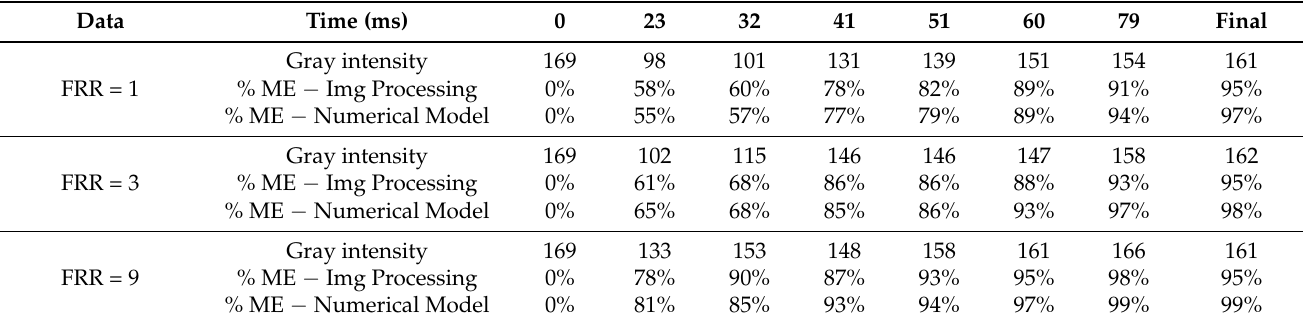
Table 4. Results of calculating gray intensity, mixing efficiency using image processing and the numerical model (AR = 0.42, TFR = 18 mL/h, Table